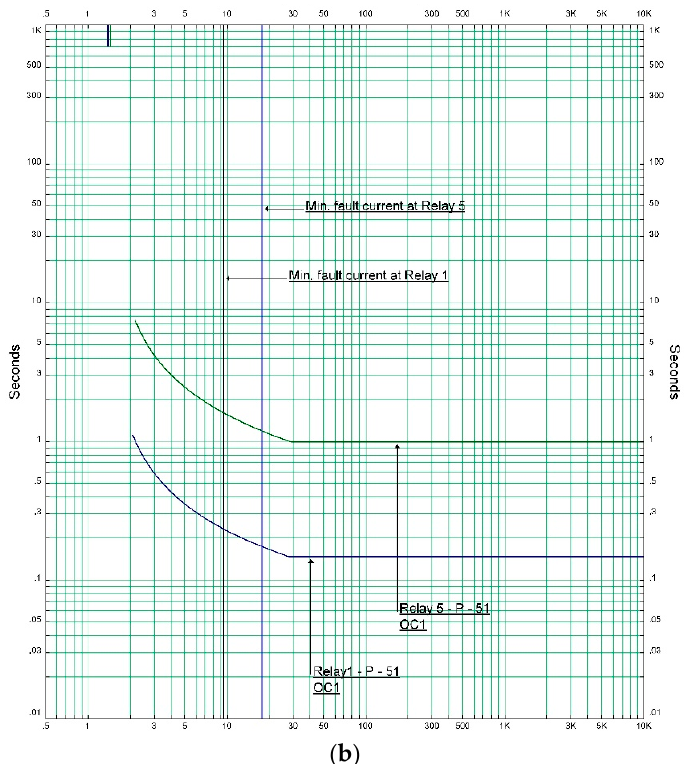
Figure 8. Time-current curves of relays 1 and 5 in case study 1 when applying: ( a ) The proposed algorithm, ( b ) The PSO algorithm.